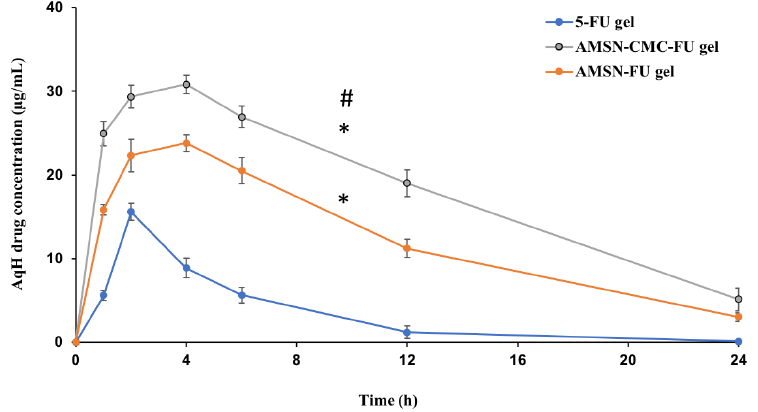
Figure 10. 5-FU concentrations in AqH following topical ocular instillation of 5-FU gel, AMSN-FU gel, and AMSN-CMC-FU gel in rabbit eyes (mean ± SD, n = 3). * Represent the significant difference between the AMSN-CMC-FU gel or AMSN-FU gel parameters in comparison to the 5-FU gel. # Represent the significant difference between AMSN-CMC-FU gel and AMSN-FU gel. 5-FU concentration in AqH in 5-FU gel formulation was lower than AMSN-CMC-FU and AMSN-FU gel formulations at all time points, which might be due to rapid corneal and precorneal loss of 5-FU in its gel form. The rate and extent of absorption and perme- ation of 5-FU from AMSN-CMC-FU gel, AMSN-FU gel, and the 5-FU gel were analyzed by comparing the pharmacokinetic parameters including C max , T max , t 1/2 , AUC, and MRT for the three treatment groups (Table 3). Table 3. Ocular pharmacokinetic (PK) parameters of 5-FU gel, AMSN-CMC-FU gel, and AMSN-FU gel (mean ± SD, n = 3). * Represent the significant difference between the AMSN-CMC-FU gel or AMSN-FU gel parameters in comparison to the 5-FU gel. # Represent the significant difference between AMSN-CMC-FU gel and AMSN-FU gel.